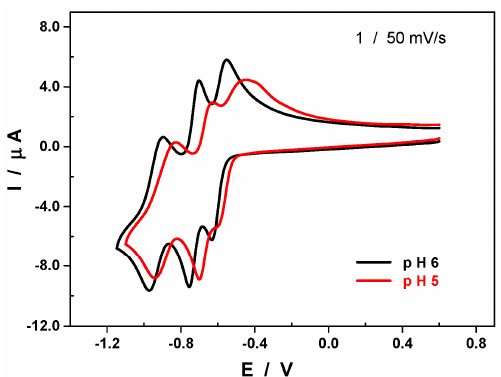
Figure 5. CV of 1 recorded in 1.0 M of LiOAc + HOAC / pH 6.0 (black) and pH 5.0 (red) at a scan rate of 50 mV.s − 1 . POM concentration: [1] = 0.20 mM. Working electrode: GC; counter electrode: Pt gauze; reference electrode: SCE.